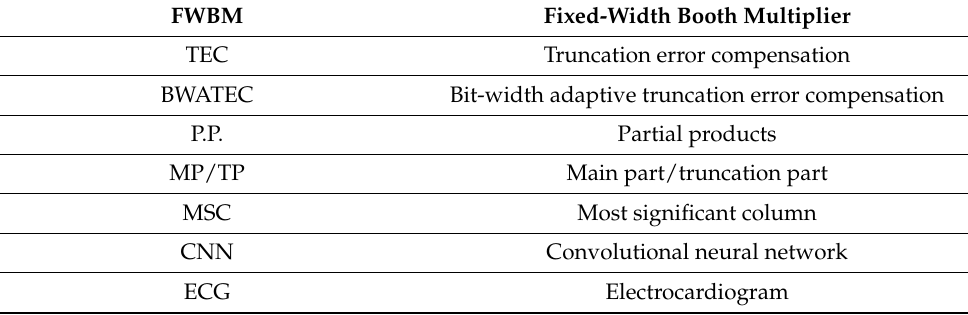
Table 1. Mapping of abbreviations and acronym